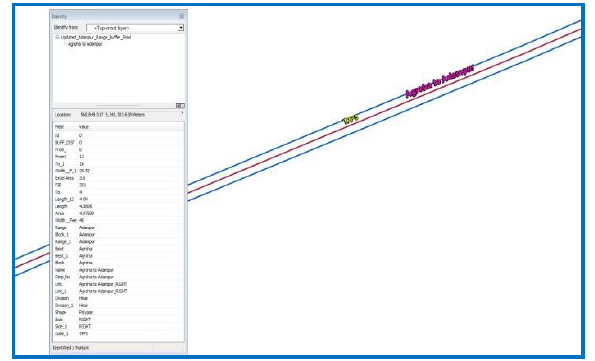
Figure 5. kml files overlaid on Google